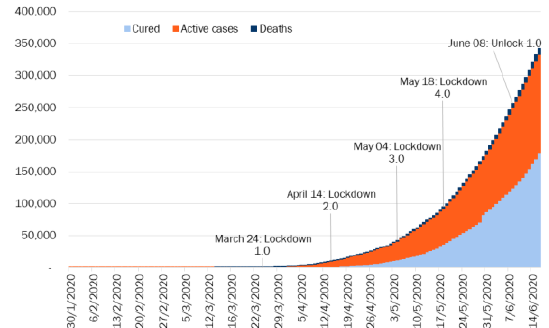
Figure 1.1: Total number of cases of Covid-19 in India [1] Fig 1.2 characterizes the technique by which the patient is firstly diagnosed with covid-19 by using CT chest